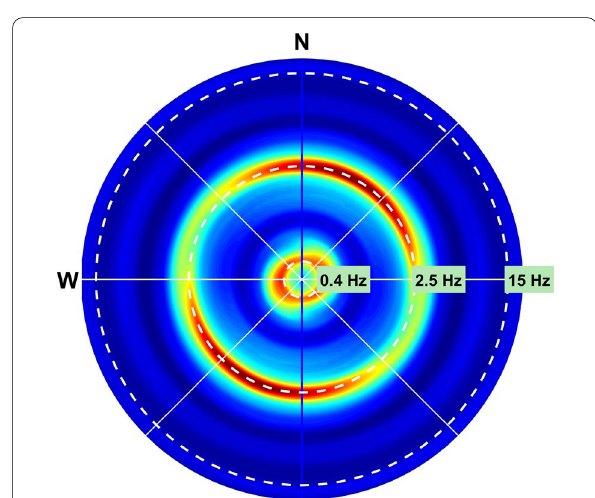
Fig. 14 Beligna#1—western area (HV2): directivity of the Horizontal-to-Vertical Spectral Ratio obtained from microtremor data (see also the average curve shown in Fig. 15c): the centre of the circle represents 0.3 Hz and the external circumference 19 Hz (for the joint analysis with the dispersion data we considered only the lower frequencies—see text for further